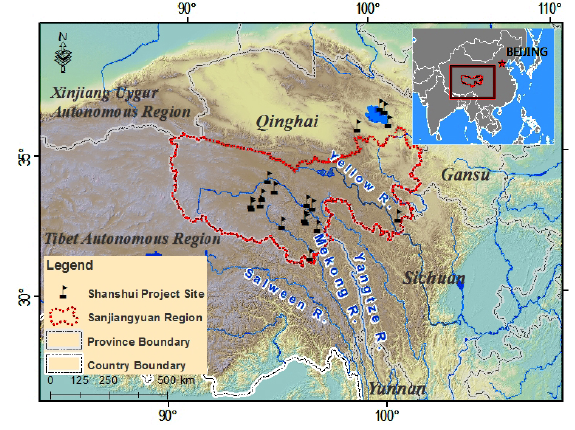
Fig. 1 . Location of the Sanjiangyuan region in China (produced by Liu